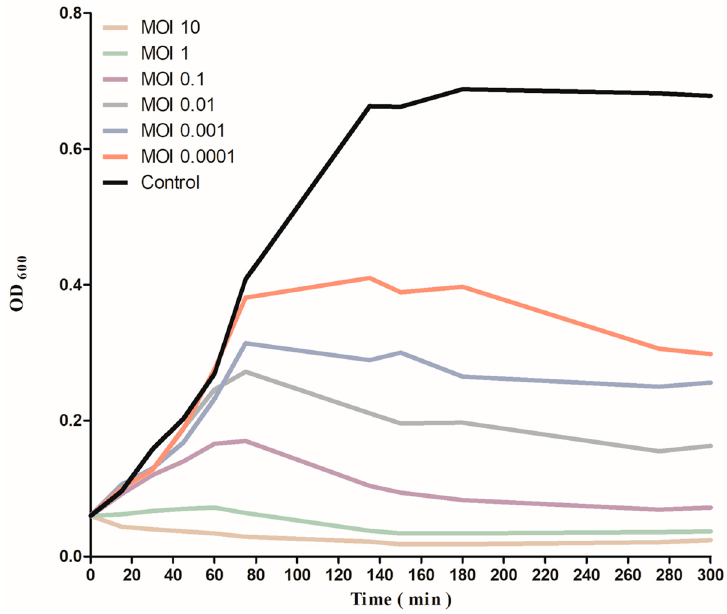
Figure 4. Reduction in S. Typhi (NCTC 160) growth by phage ZCSE9 at different MOIs.